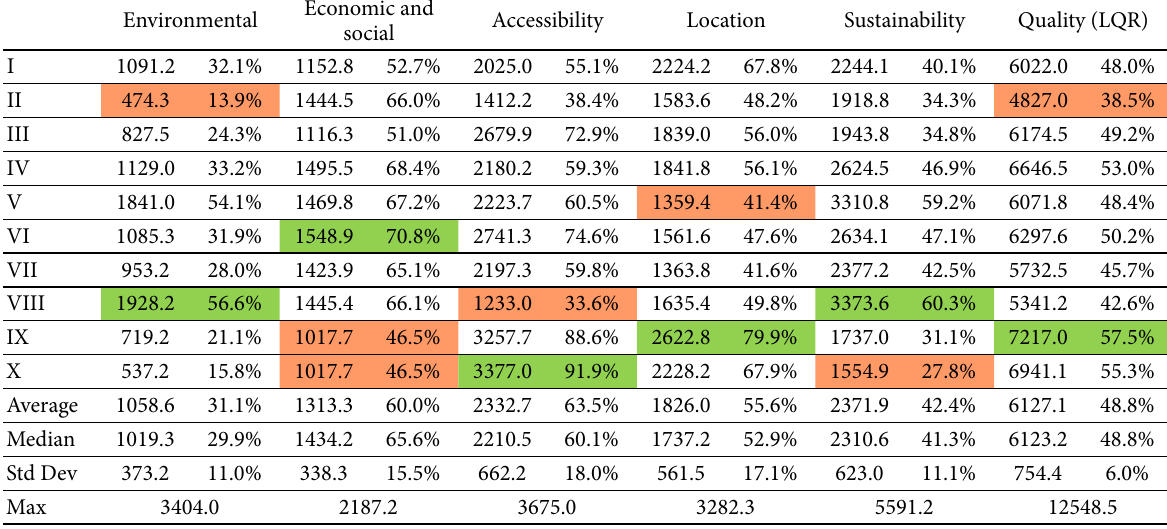
Table 5. MCDA algorithm